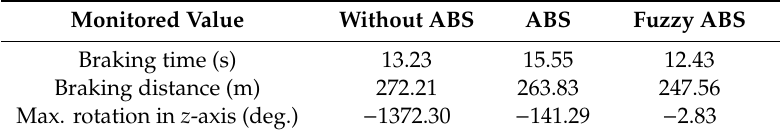
( c ) Figure 15. Maneuverability test on dry road at speed 100 km/h—( a ) Speed curve; ( b ) Braking distance; ( c ) Vehicle trajectory. Table 7. Maneuverability test on dry road at speed 100 km/h. Monitored Value